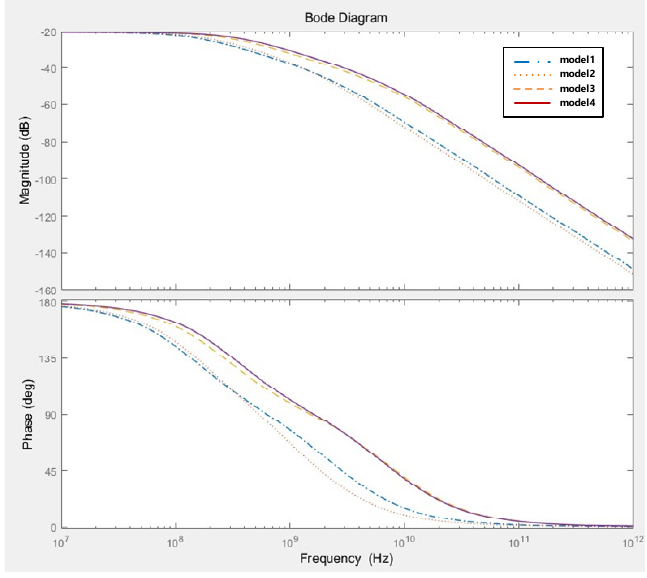
Figure 8. Frequency response characteristics in different coil models with the same mutual inductance value of 2.8 nH.